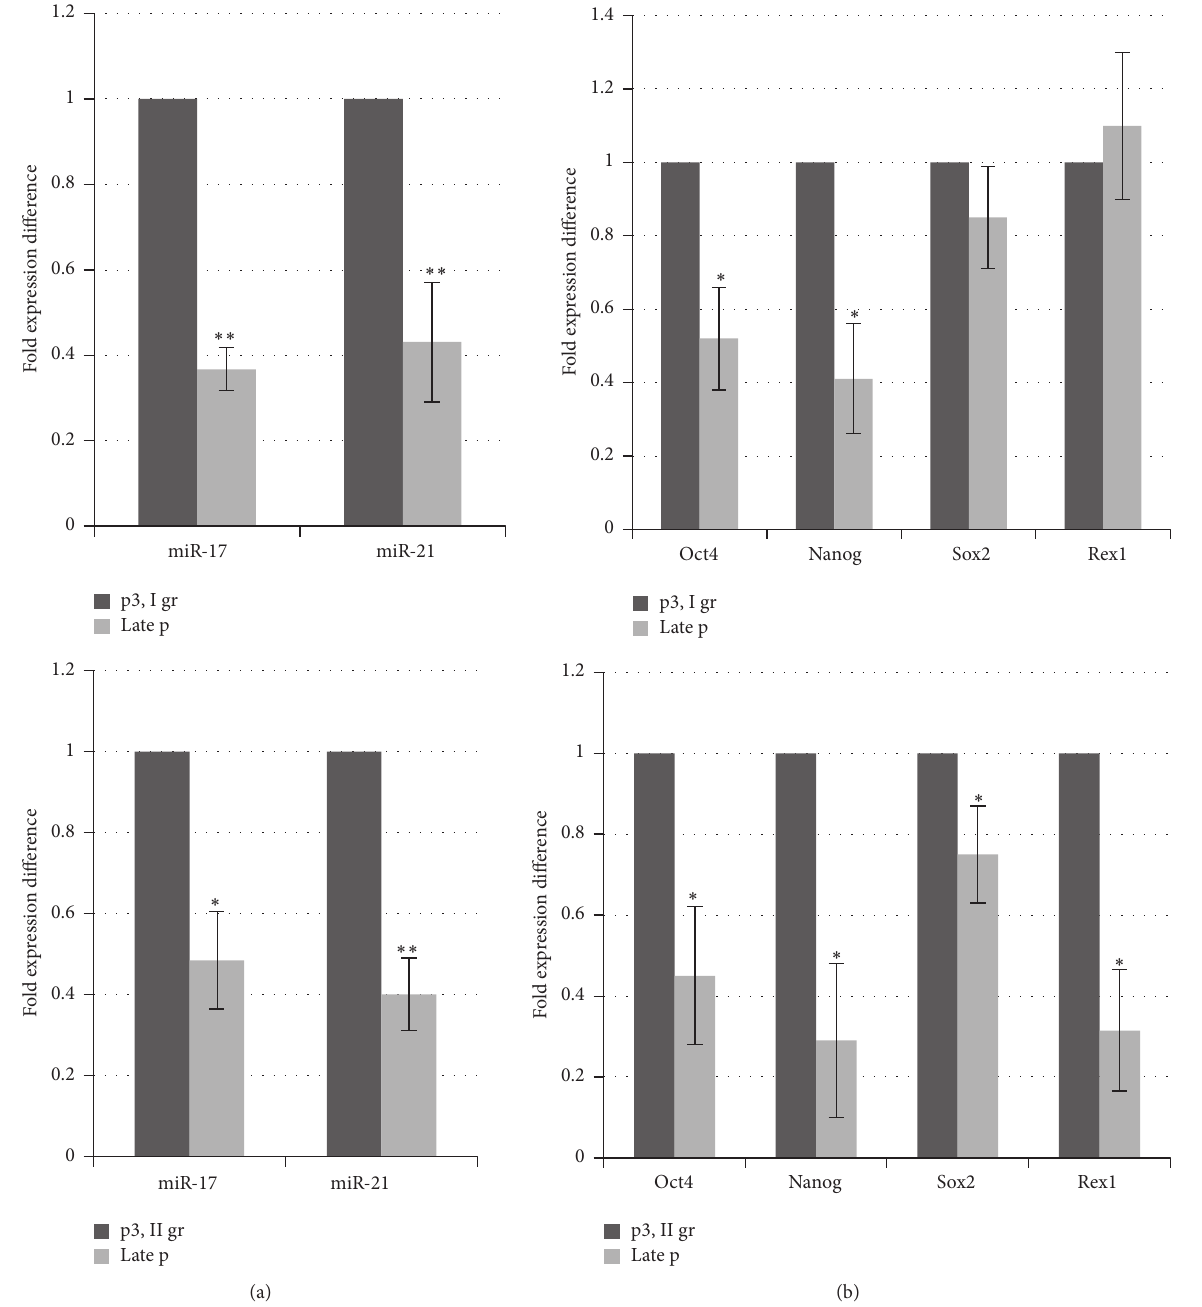
Figure 4: Differential expression of miRNAs and stem cell markers in MSCs cultures during passaging. RT-qPCR analysis of miR-17 and miR-21 (a) and Nanog, Oct4, Sox2, and Rex1 (b) from cell cultures of two groups (I and II) at passage 3 and the late passage. Normalization to calibrator sample (a) or GAPDH (b) and fold expression difference as compared with passage 3 calculated using a comparative threshold cycle delta-delta Ct method. The data is presented as the mean ± SD ( 𝑛 = 3 , from each group). ∗ 𝑃 ≤ 0.05 and ∗∗ 𝑃 ≤ 0.01 were considered as significant